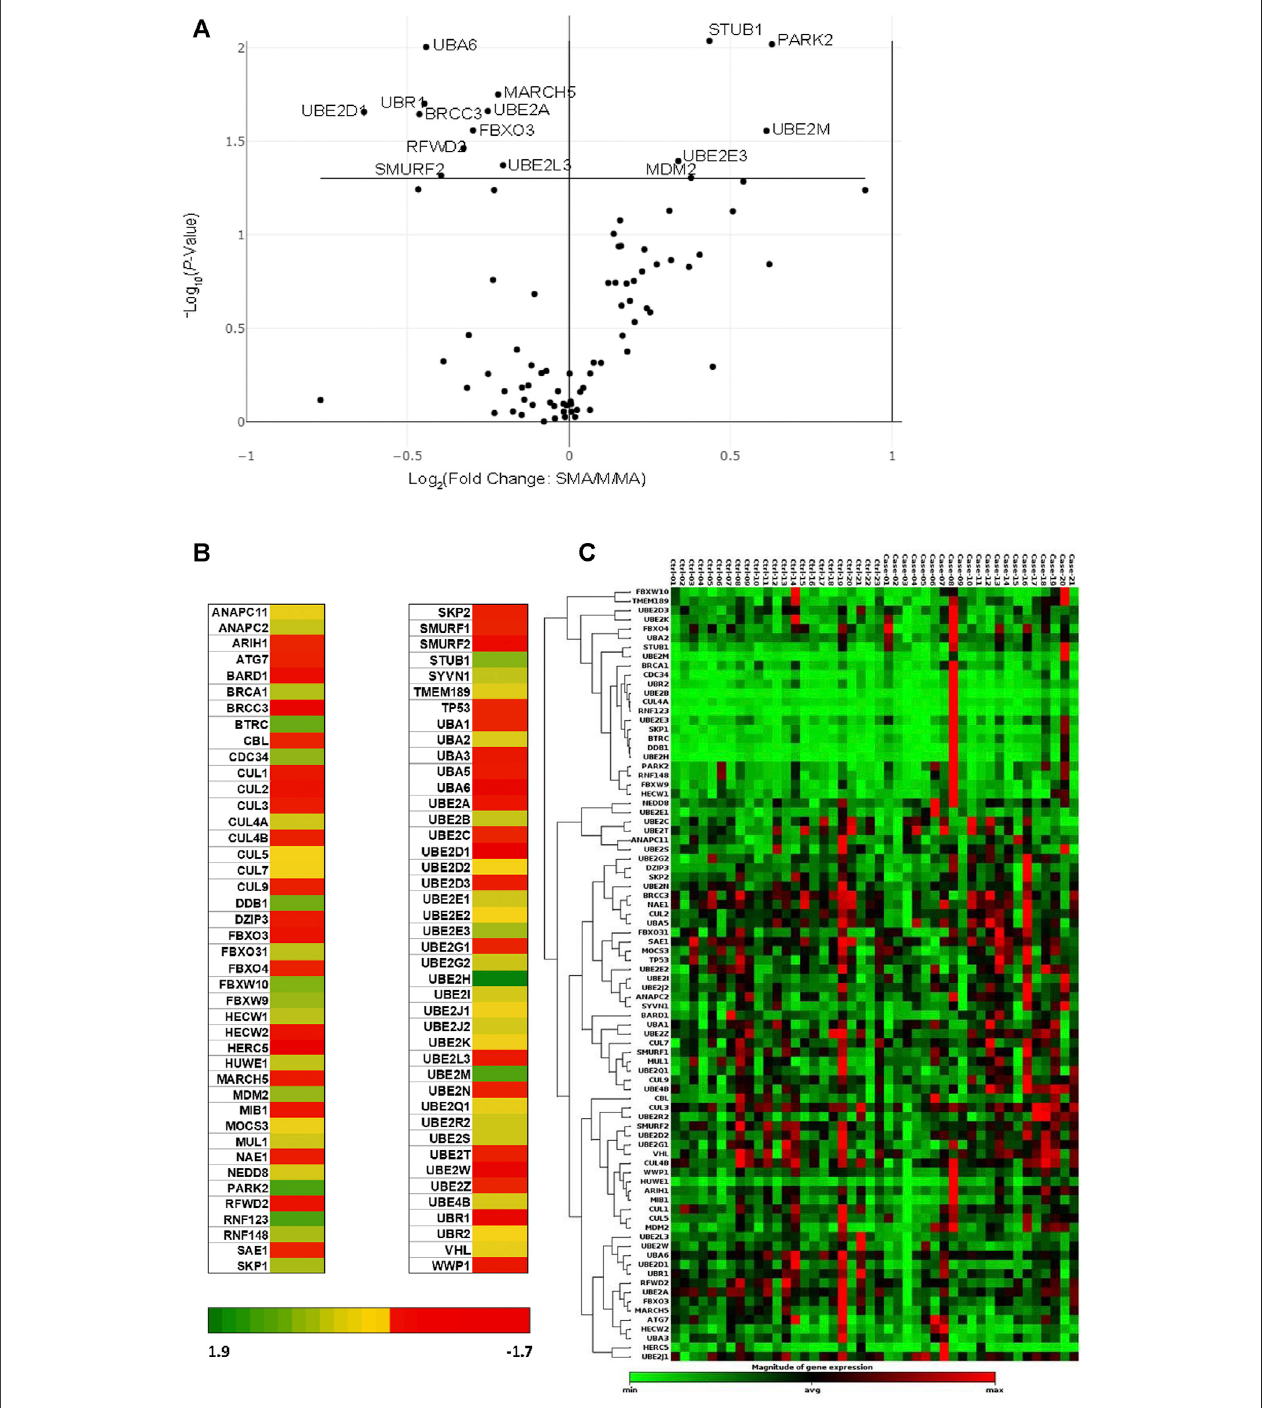
FIGURE 1 | Comparison of ubiquitination gene expression levels. Children ( n (cid:1) 44), with mild malarial anemia (M l MA; Hb ≥ 9.0 g/dl, n (cid:1) 23) and severe malarial anemia (SMA; Hb < 6.0 g/dl, n (cid:1) 21) were enrolled into the study. Gene expression pro fi les were measured using the Human Ubiquitylation Pathway RT 2 Pro fi ler PCR Array kit. Geometric mean was used as a normalization factor, and data standardized using fi ve housekeeping genes [Actin, beta (ACTB), Beta-2-microglobulin (B2M), Glyceraldehyde-3-phosphate dehydrogenase (GAPDH), Hypoxanthine phosphoribosyltransferase 1 (HPRT1) and Ribosomal protein, large, P0 (RPLPO)]. Data were analyzed by the ΔΔ C T method (2 − ΔΔ C T ) (Livak and Schmittgen, 2001), using the RT 2 Pro fi ler PCR Array Data Analysis Webportal (Qiagen, United States). Fold regulationset at 1.5,and p ≤ 0.050. (A) .TheVolcano Plot showsgene expression changesthatplots thelogbase2ofeach genefoldchange valueon the x -axis versus the negativelogbase 10 ofeach genes p -value on the y -axis. The center vertical lineindicates unchanged gene expression, while thetwo outer vertical lines indicate the